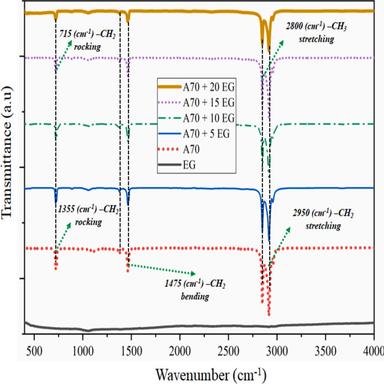
FTIR spectra of base (A70) PCM and the SS-PCM composites.